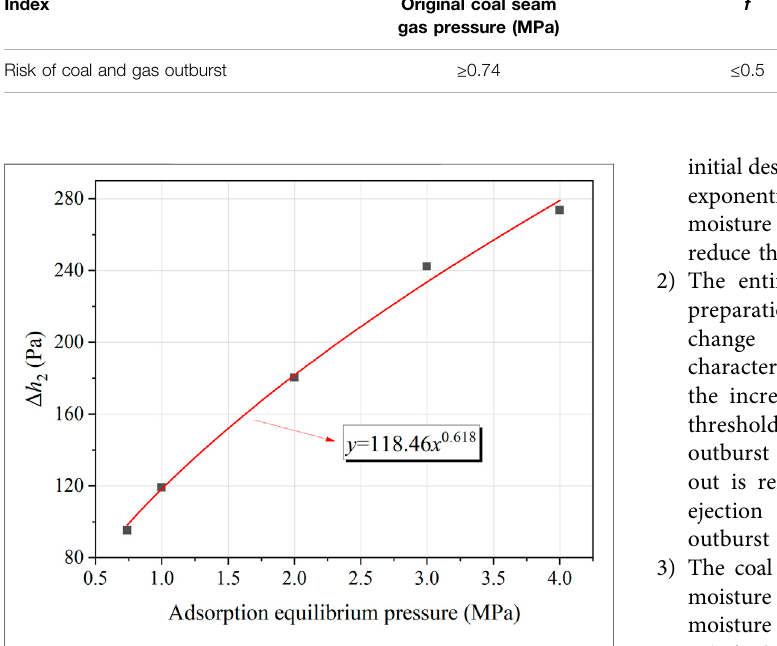
Frontiers in Earth Science |